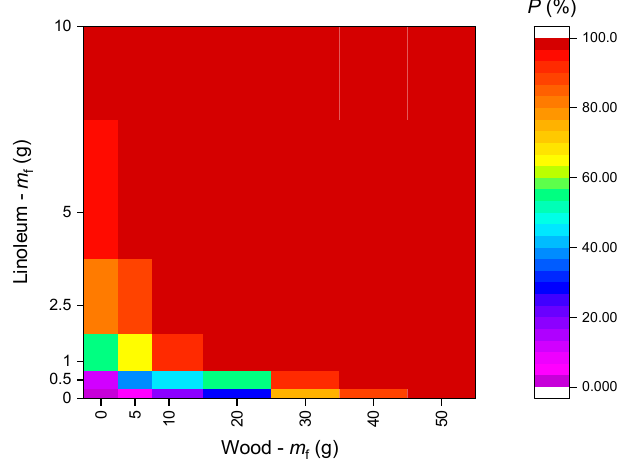
Figure 24. Probability of SD activation vs. mass of linoleum and wood (when several fuels are involved in a model fire).